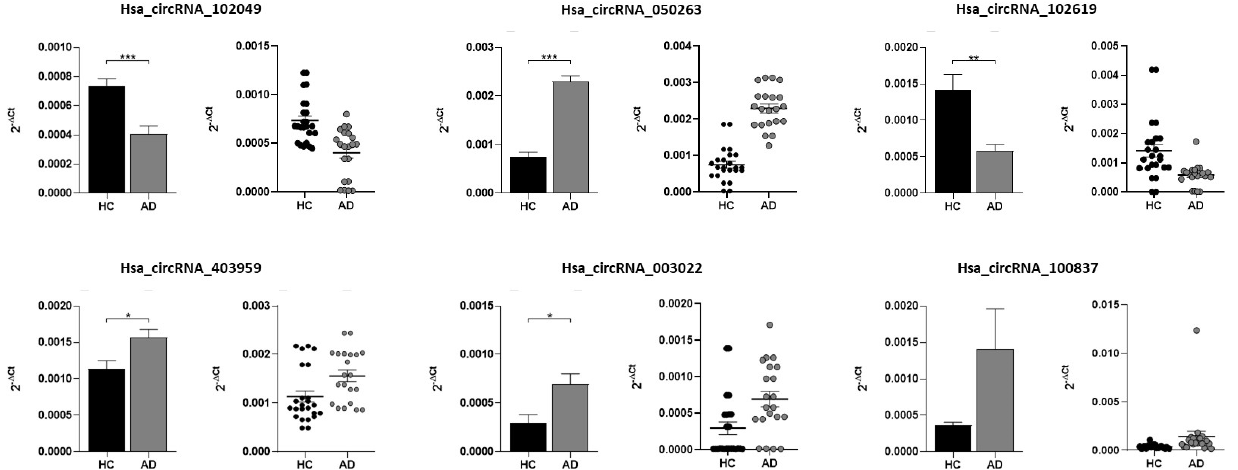
Figure 1. Graphic representation and Scatter plots of circRNAs levels between AD patients and HCs. * p < 0.05, ** p < 0.01, *** p < 0.001.